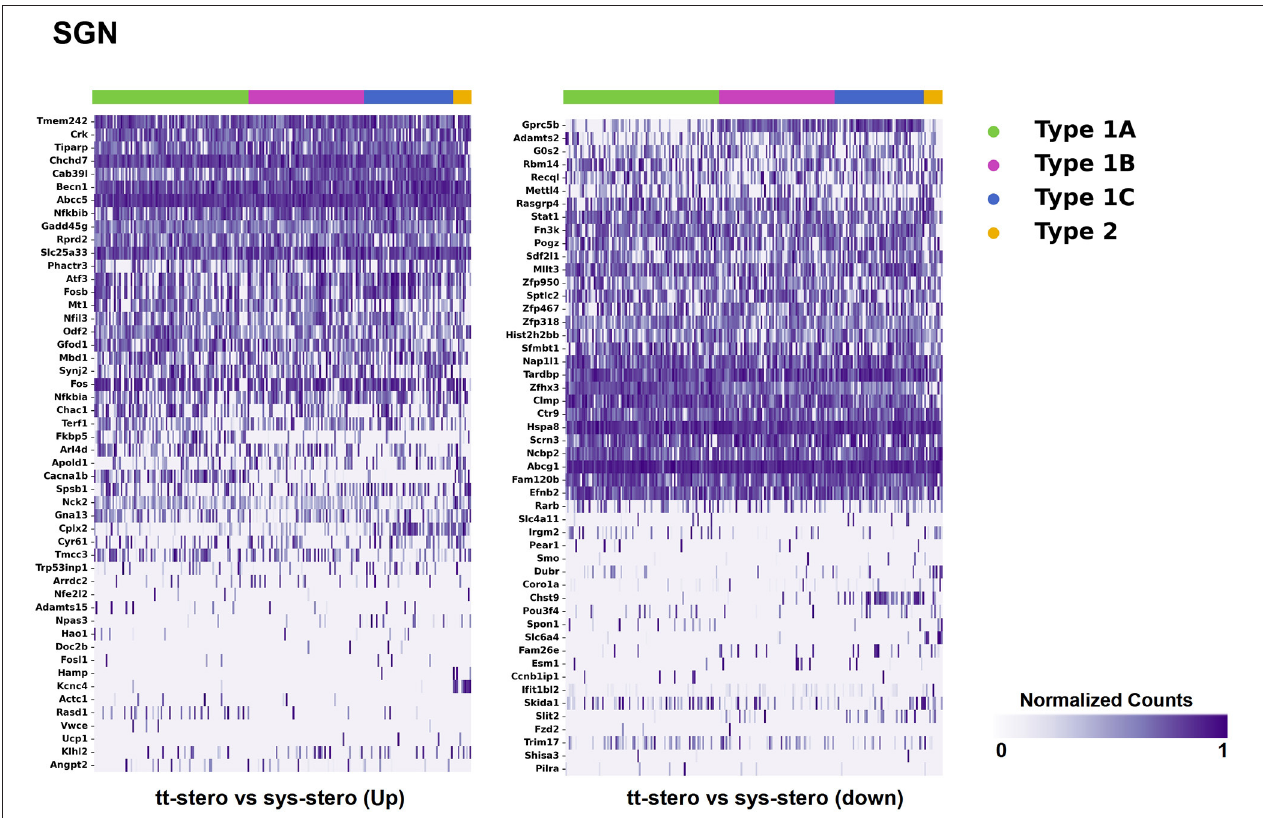
FIGURE 3 | Steroid-responsive gene expression in the adult mouse spiral ganglion neurons after treatment with transtympanic vs. systemic steroids. Expression of steroid-responsive genes from mice treated with transtympanic vs. systemic steroids in an adult mouse spiral ganglion neuron (SGN) single-cell RNA-Seq dataset ( 18). Heatmap (LEFT) localizes genes with increased expression in mice treated with transtympanic vs. systemic steroids to cell types in the adult mouse SGN. Heatmap (RIGHT) localizes genes with decreased expression in mice treated with transtympanic vs. systemic steroids to cell types in the adult mouse SGN. Heatmaps display cells along the horizontal axis with cell types grouped by color with each bar denoting a single cell and genes are displayed along the vertical axis. The darker the bar, the more highly expressed the gene is in a given cell. Expression level is displayed in normalized